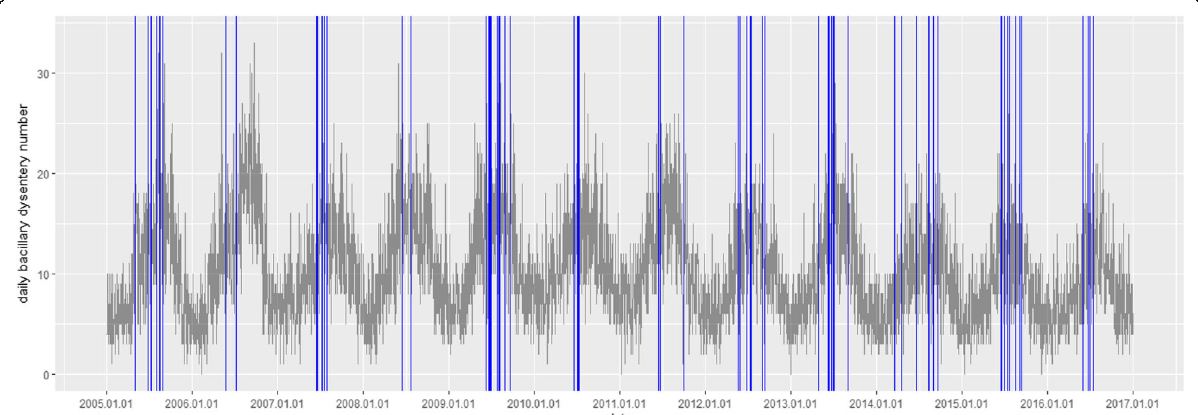
Fig. 1 Distribution of daily bacillary dysentery cases during study period from 2005 to 2016 in main urban areas of Chongqing, China (Day with flood is indicated as blue line.)